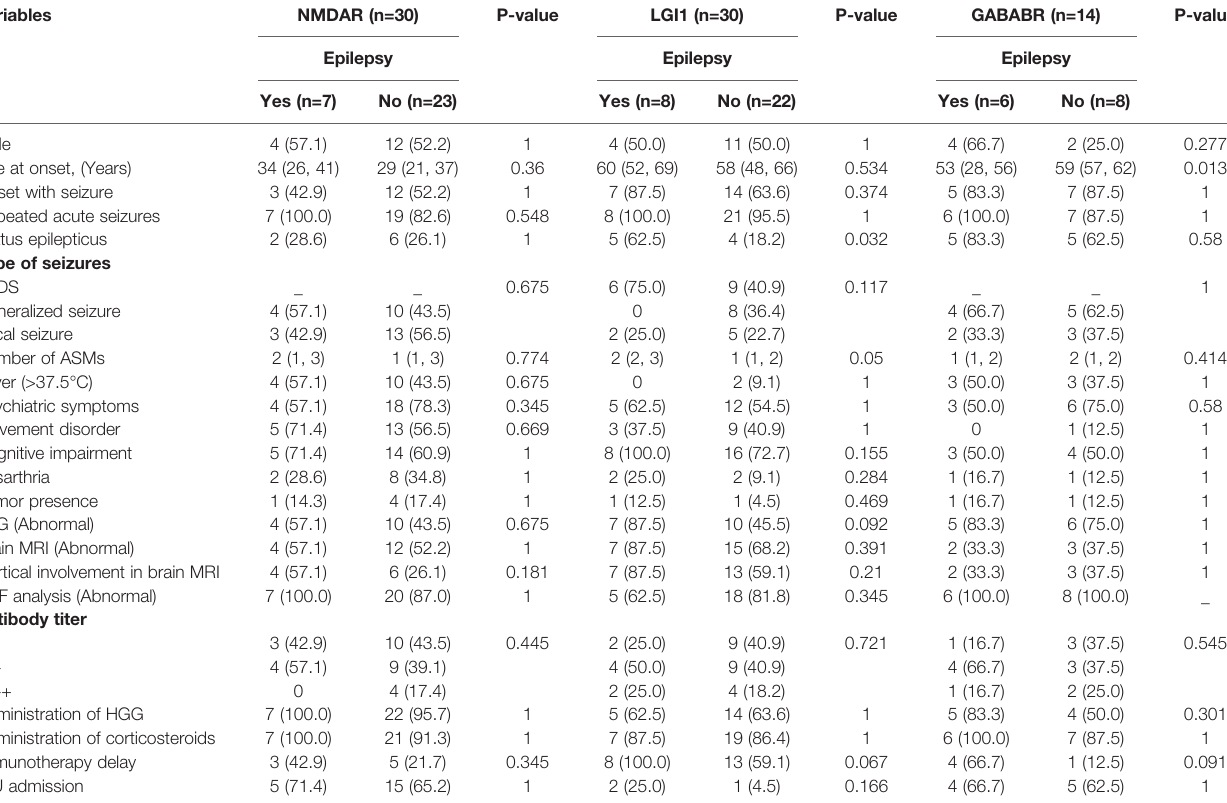
TABLE 6 | Univariate analysis of factors associated with the development of epilepsy in patients with anti-NMDAR, anti-LGI1, and anti-GABABR encephalitis. Variables